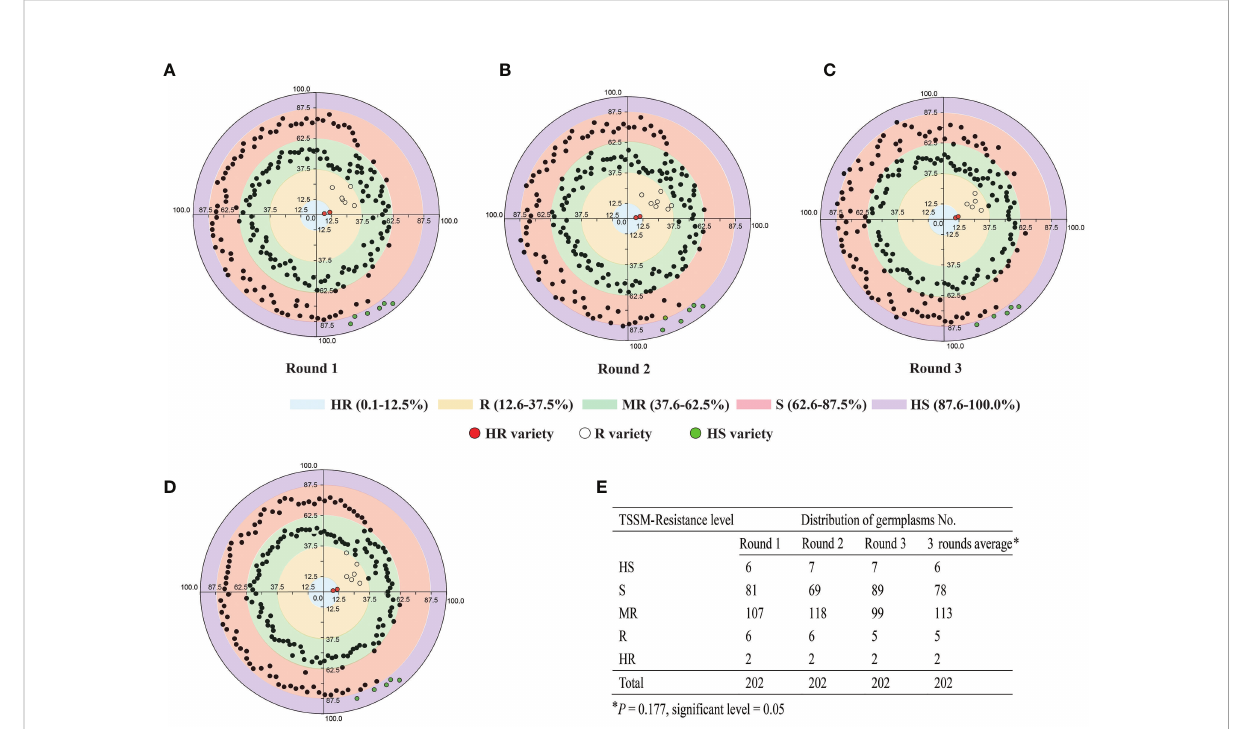
FIGURE 2 Three rounds of greenhouse identi fi cation of 202 cassava germplasm resistance to two-spotted spider mite. (A) First round of greenhouse identi fi cation. (B) Second round of greenhouse identi fi cation. (C) Third round of greenhouse identi fi cation. (D) Average of three rounds of greenhouse identi fi cations. The different color zones indicated the different resistant levels; moreover, the values on the axes indicated the mite damage index ranges that distinguish different levels of resistance. In addition, the identi fi ed HR, R, and HS varieties were marked as red, white and green circles; other MR or S varieties were marked as black circles, respectively. (E) Summary data of the three rounds of greenhouse identi fi cation. The data was analyzed separately (for each round) or combined (three round average). The asterisk indicates that there is no signi fi cant difference ( P = 0.177) of resistance levels among the three rounds of screening, and the results can be combined for analysis as validated by the non-parametric test method (Kruskal – Wallis test for independent